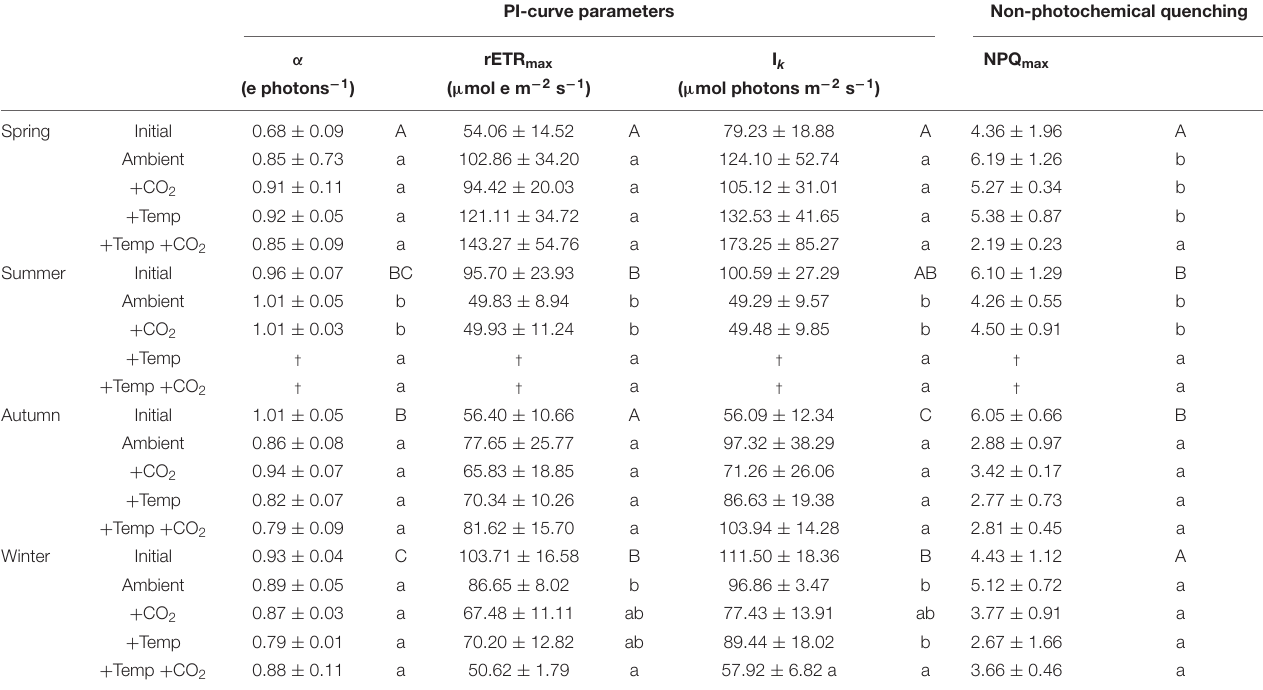
TABLE 1 | Photophysiological responses of initial Fucus vesiculosus individuals growing in its native habitat ( n = 12) and at the end of the experiments in the Kiel Outdoor Benthocosms ( n = 3), with manipulated temperature and pCO 2 conditions over different seasons. PI-curve